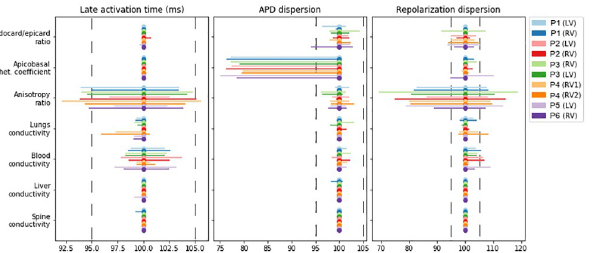
Fig 6. Variation in the temporal characteristics of depolarization and repolarization (see annotation on top of the panels) in the models under univariable parameter variation (see annotation in the left column); 100% on the horizontal axis indicates the reference model values. The bars show the spans of characteristics from the minimum to maximum relative to the reference. Color annotation indicates the patients (P1–P6) and the position of the electrode stimulation (LV or RV). Vertical dashed lines show a ± 5% deviation from the reference.